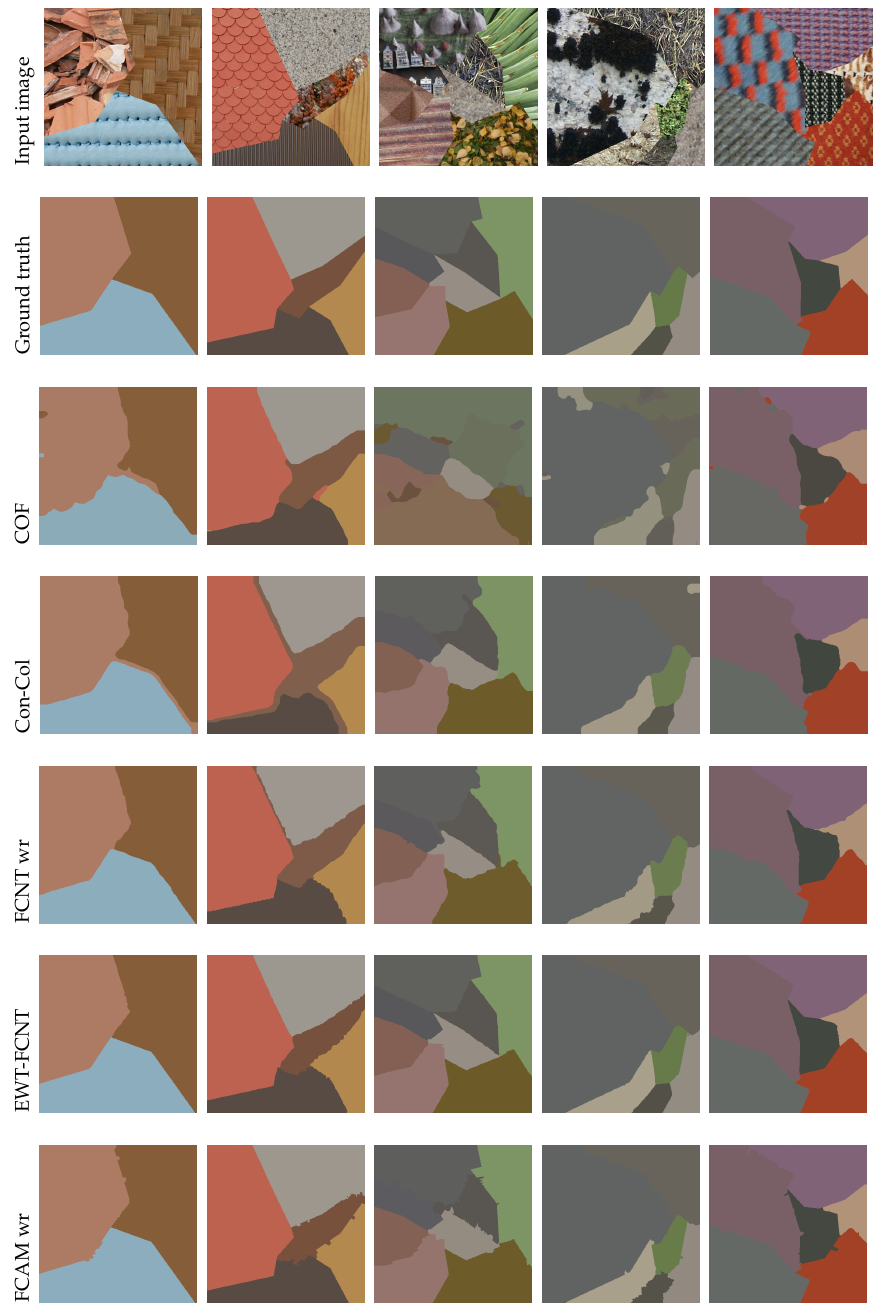
Figure 7. Sample segmentation results on Prague dataset, from left to right: image 01, image 03, image 06, image 15, and image